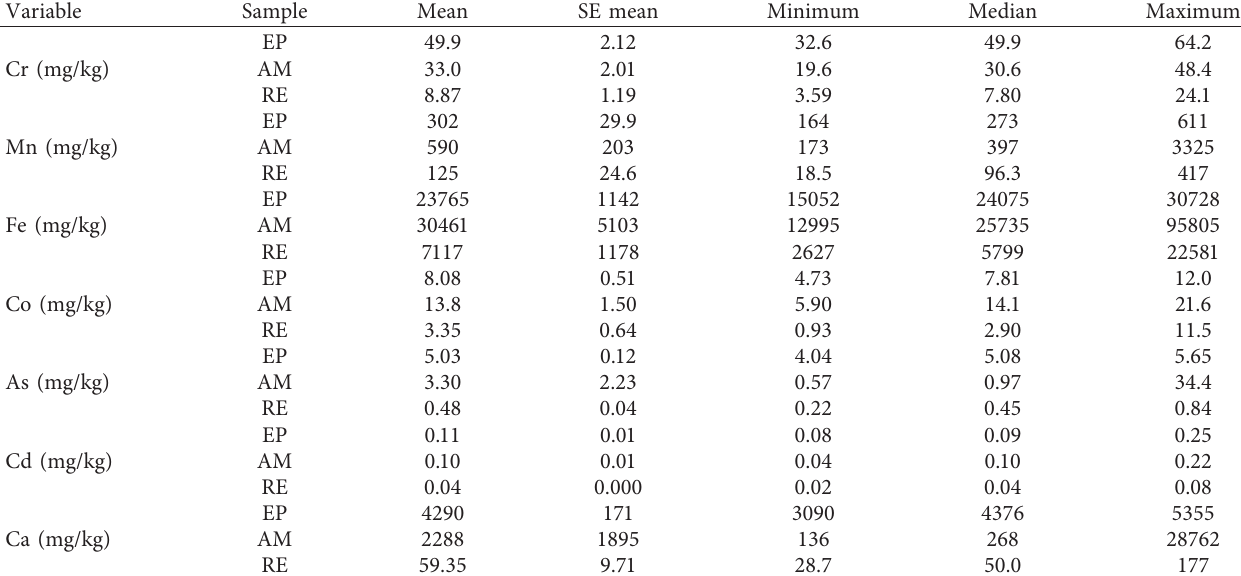
Table 4: Descriptive statistics on concentrations of environmental toxicants including toxic metals/metalloids and phosphates of paddy soil samples (CKDu hotspots: Eppawala (EP) and Ambagaswewa (AM) GNDs, and the reference: Dambethalawa (RE) GND).